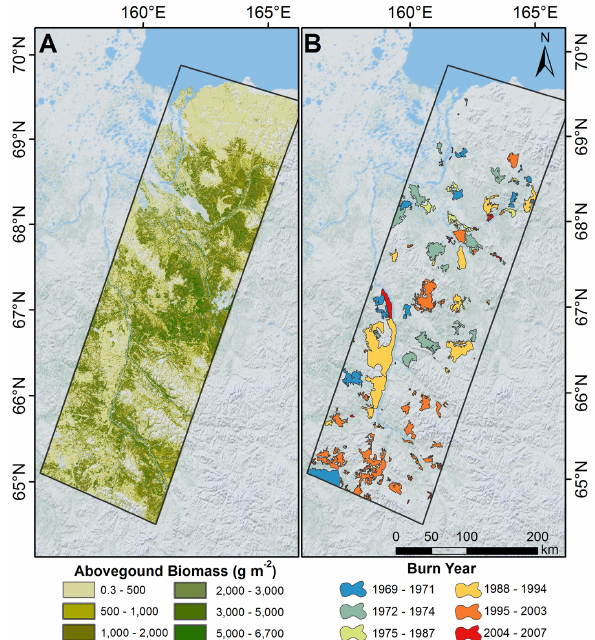
Fig. 4. Maps of the northeastern portion of the Kolyma River wa- tershed showing (a) aboveground biomass of Cajander larch and (b) burn scar perimeters for fires that occurred c. 1969–2007. Both datasets were derived primarily from 30m resolution Landsat im-